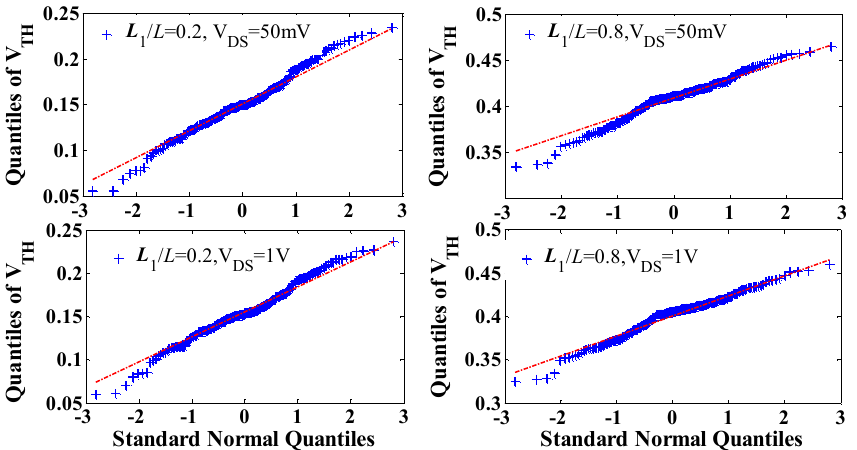
Figure 4. Quantile-quantile plots of V TH with L 1 / L = 0.2 and 0.8.